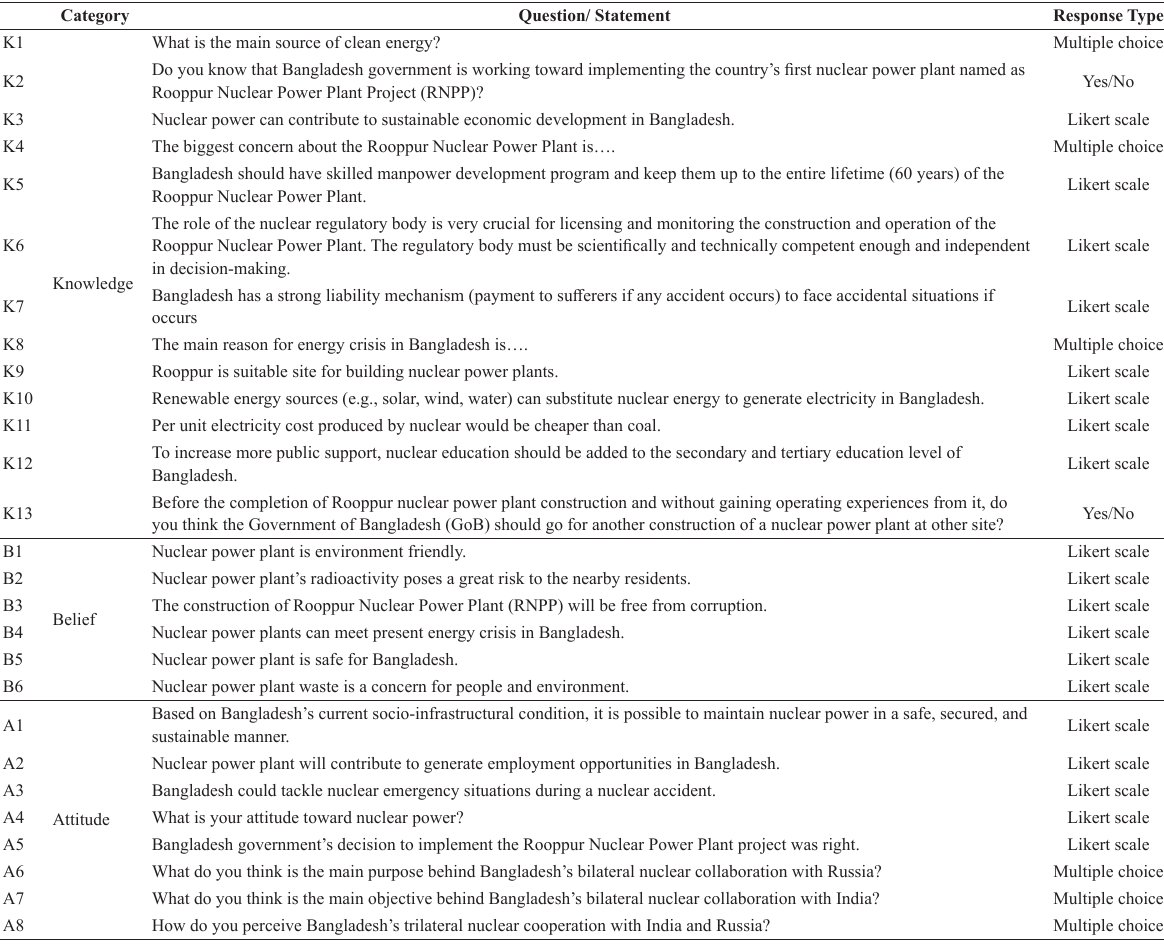
Table 2. Types of latent variable, question/statement, and answering options for this study